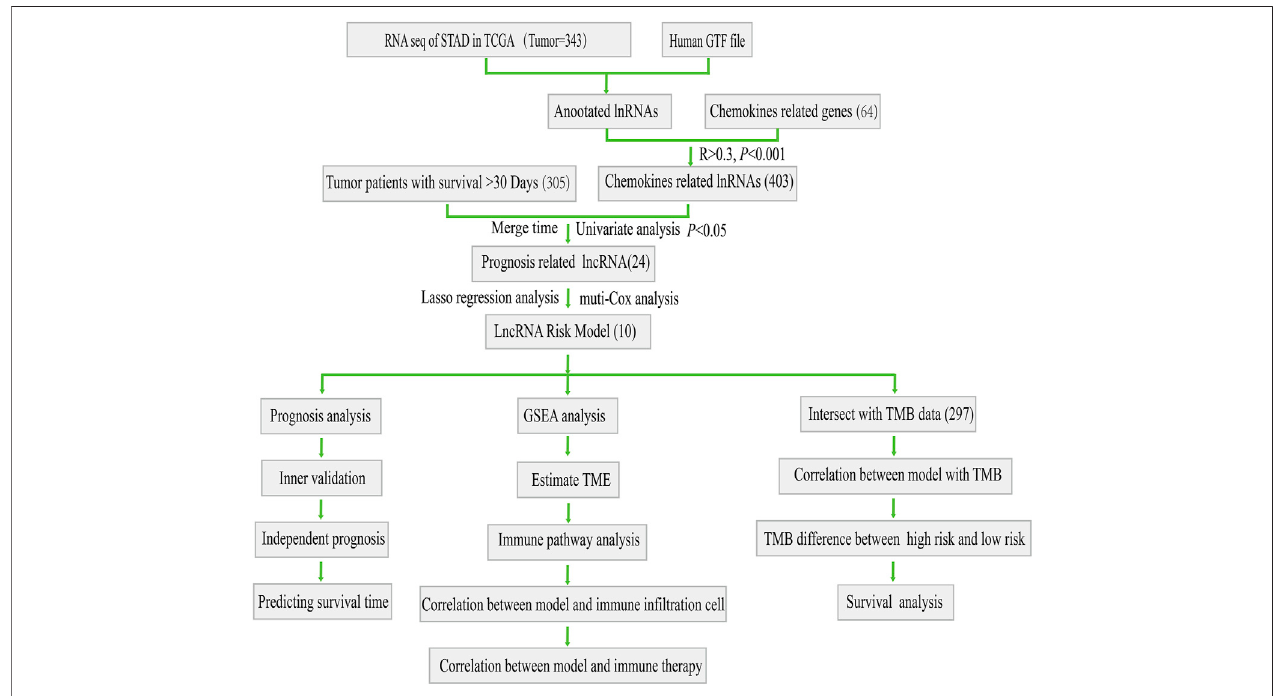
FIGURE 1 | Flow chart of this